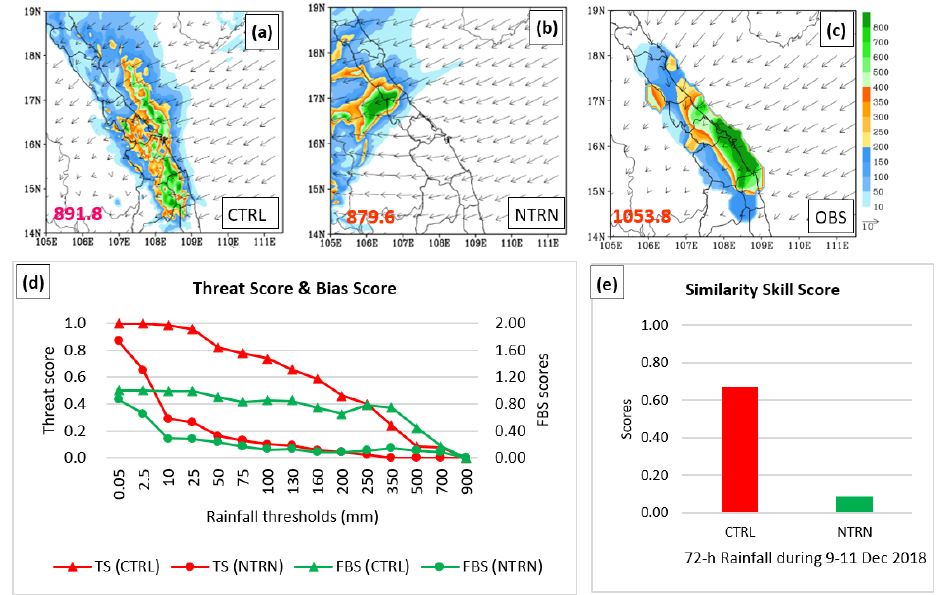
Figure 14. (a–c) As in Fig. 12a–c, except for 3d averaged surface horizontal wind vectors and 72h accumulated rainfall over 9–11 December 2018. (d, e) As in Fig. 13c, d, except for TS and SSS values of the 72h accumulated rainfall over 9–11 December